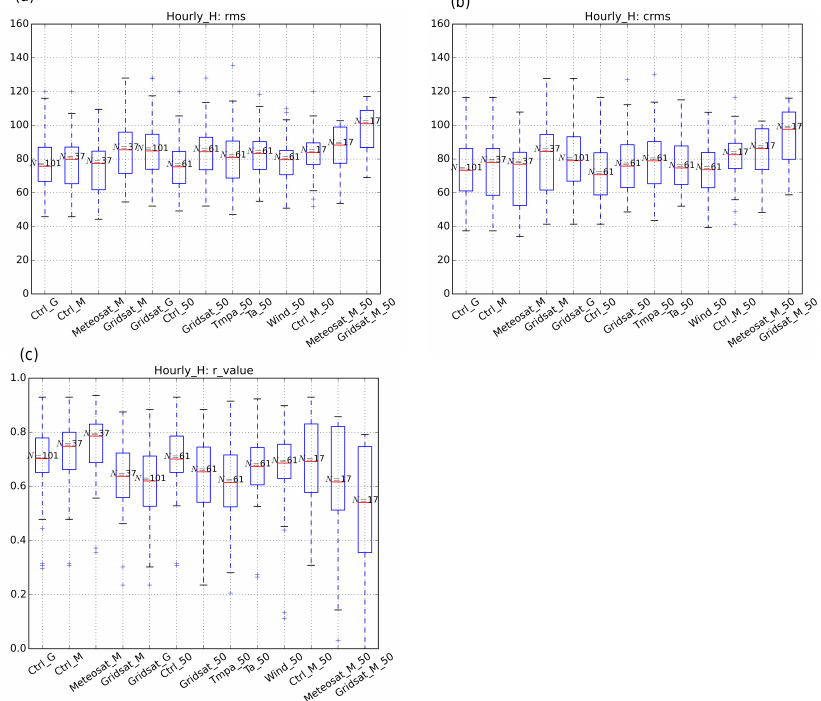
Figure 10. Box plots of (a) RMSD, (b) cRMSD and (c) correlation coefficient for HOLAPS sensible heat